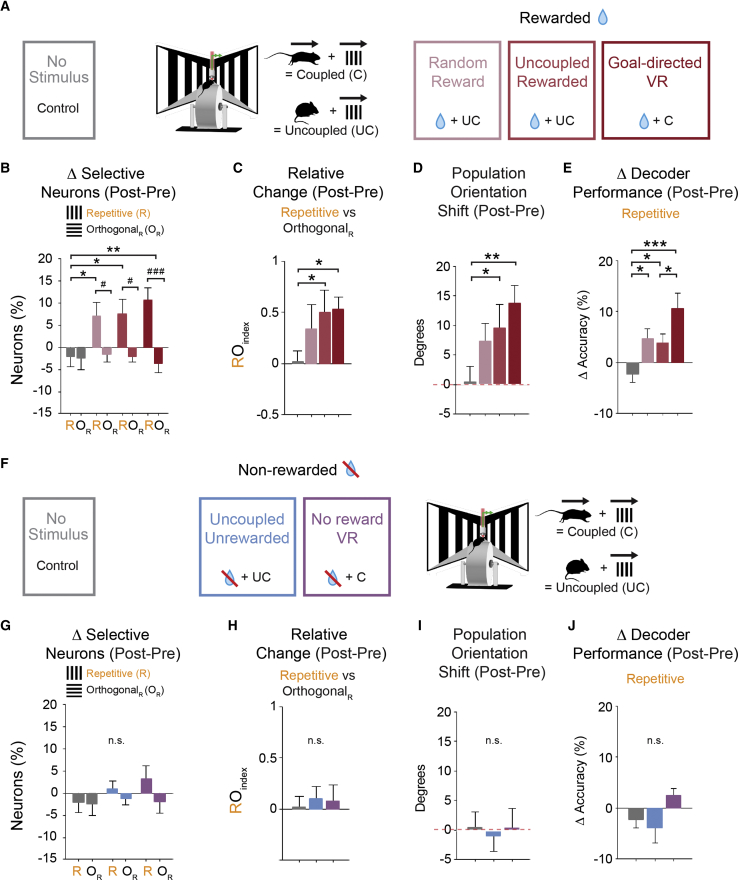
Stimulus-Specific Enhanced Representation following Reward Association(A) Rewarded experimental groups. Over the 5 days of repeated exposure to the oriented grating, mice received a water reward either randomly (random reward) or during a learning task within the specified reward zone (uncoupled-rewarded and goal-directed VR). The same visual stimulus was displayed in a virtual environment either uncoupled (random reward and uncoupled-rewarded) or coupled to the mice locomotion (goal-directed VR). The group with no stimulus presentation over 5 days was used as a control.(B) Change in the proportion of selective neurons from pre to post day compared between the R and OR gratings within groups (#p < 0.05; ###p < 0.001; goal-directed VR: p < 0.001; uncoupled-rewarded: p = 0.013; random reward: p = 0.025; Student’s t test) and the change in proportion of R selective neurons compared across groups (p = 0.023; one-way ANOVA with LSD test; ∗p < 0.05; ∗∗p < 0.01).(C) Relative change from pre to post day between the R and OR gratings (ROindex; p = 0.032; one-way ANOVA with LSD test; ∗p < 0.05).(D) Shift in the orientation selectivity at the population level from pre to post day. Difference in the average maximal response vector across all neurons for each animal is shown as the mean across animals for each group (n = 9 mice for each). Bars above the red dashed line indicate a shift toward the R grating, and bars below the dashed line indicate a shift away from the R grating (p = 0.039; one-way ANOVA with LSD test; ∗p < 0.05; ∗∗p < 0.01).(E) Change in the decoding accuracy across groups for the R grating from pre to post day using a Bayesian maximum-likelihood decoder to determine individual neuronal response and averaged across the population for each animal (p = 0.003; one-way ANOVA with LSD test; ∗p < 0.05; ∗∗∗p < 0.001).(F) Non-rewarded experimental groups. Over the 5 days of repeated exposure to the oriented grating, visual stimulus was displayed in a virtual environment either uncoupled (uncoupled-unrewarded) or coupled (no reward VR), with all groups receiving no reward. The group with no stimulus presentation over 5 days was used as a control.(G) Change in the proportion of selective neurons from pre to post day compared between the R and OR gratings within groups was non-significant for all groups (no stimulus: p = 0.641; uncoupled-unrewarded: p = 0.322; no reward VR: p = 0.301; Student’s t test) and the change in proportion of R selective neurons not significant across groups (p = 0.310; one-way ANOVA).(H) Relative change from pre to post day between the R and OR gratings (ROindex) was non-significant across non-rewarded groups (p = 0.895; one-way ANOVA).(I) Shift in the orientation selectivity at the population level from pre to post day was non-significant across non-rewarded groups (p = 0.921; one-way ANOVA).(J) Change in the decoding accuracy for the R grating from pre to post day was non-significant across non-rewarded groups (p = 0.123; one-way ANOVA).All panels: n = 9 mice for each group; error bars: SEM.See also Figure S3 and Table S2.